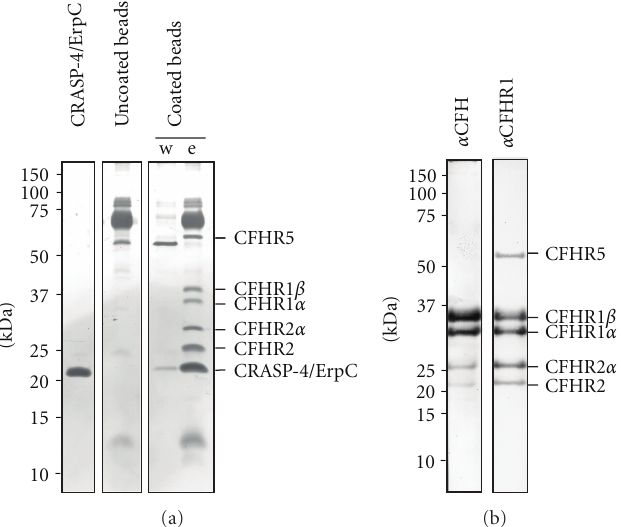
Figure 1: Identification of serum proteins that bind to recombinant CRASP-4. Recombinant, polyhistidine-tagged CRASP-4 was immo- bilized onto magnetic beads and incubated with NHS. Uncoated beads were also treated under the same conditions and used as a control to identify nonspecific binding of serum proteins. After extensive washing, bound proteins were eluted with 100mM glycine-HCl (pH 2.0) and the eluate fractions were separated by SDS-PAGE under nonreducing conditions. (a) Silver stain of a gel loaded with purified polyhistidine- tagged CRASP-4 (1 μ g), eluate fraction of the uncoated beads, and the final wash and eluate fraction of CRASP-4-coated beads. (b) Western blot analysis of the eluate fraction of CRASP-4-coated beads using a polyclonal anti-CFH or a polyclonal anti-CFHR1 antiserum. Mobilities of molecular mass standards are indicated to the left.